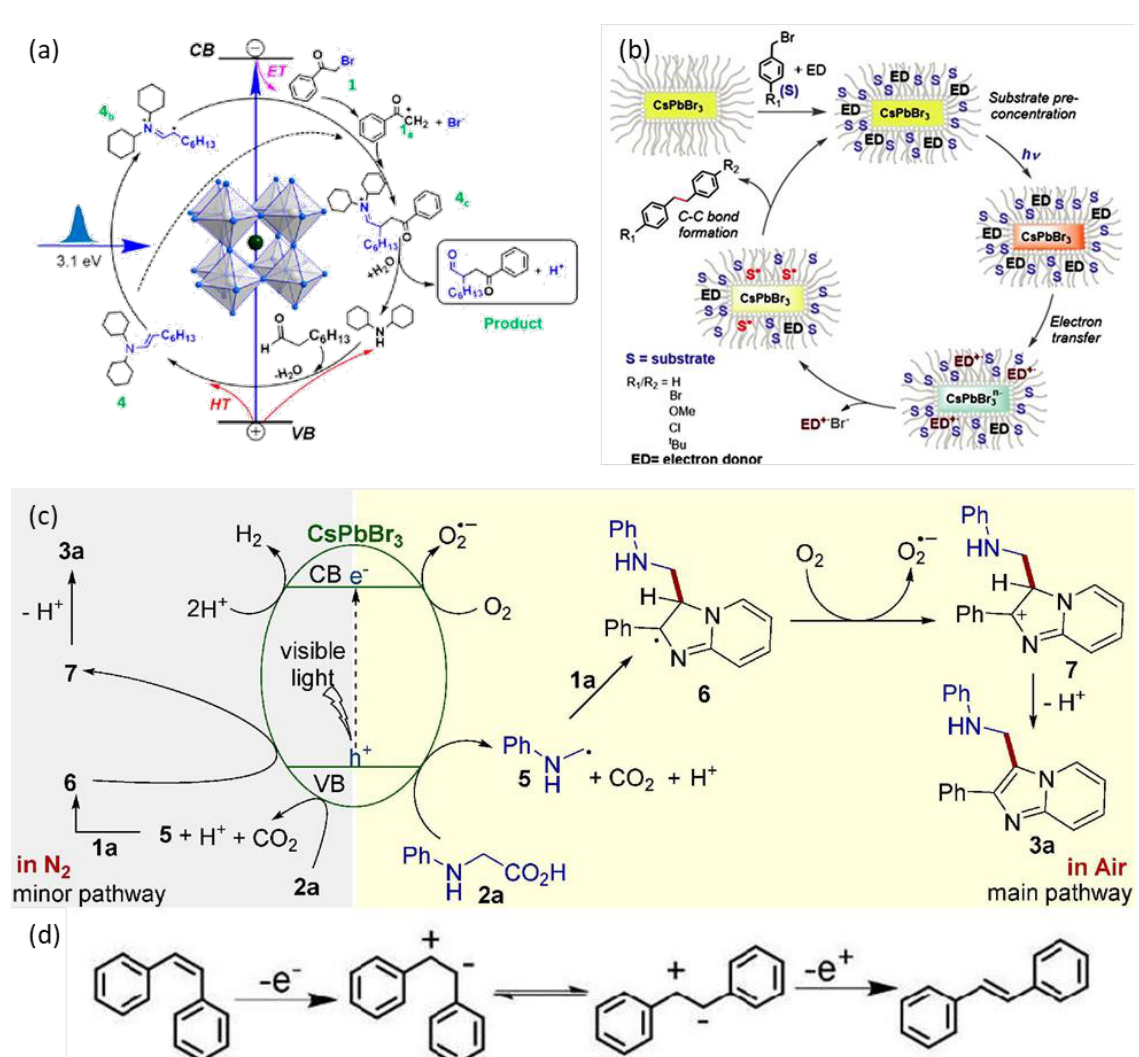
Figure 2. Proposed reaction mechanisms: ( a ) for the α -alkylation catalyzed by CsPbBr 3 NCs. For details, see ref. [27]. Reprinted with permission from ref. [27]. Copyright 2020 ACS Energy Letters. ( b ) for the coupling reaction, through cooperative action between the NC surface and the ligand. For details, see ref. [28]. Reprinted with permission from ref. [28]. Copyright 2020 ChemComm. ( c ) for the decarboxylative coupling reaction. For details, see ref. [29]. Reprinted with permission from ref. [29]. Copyright 2020 Adv. Synth. Catal. ( d ) for the photocatalytic cis-to-trans stilbene isomerization. For details, see ref. [30]. Reprinted with permission from ref. [30]. Copyright 2019 ChemCatChem.